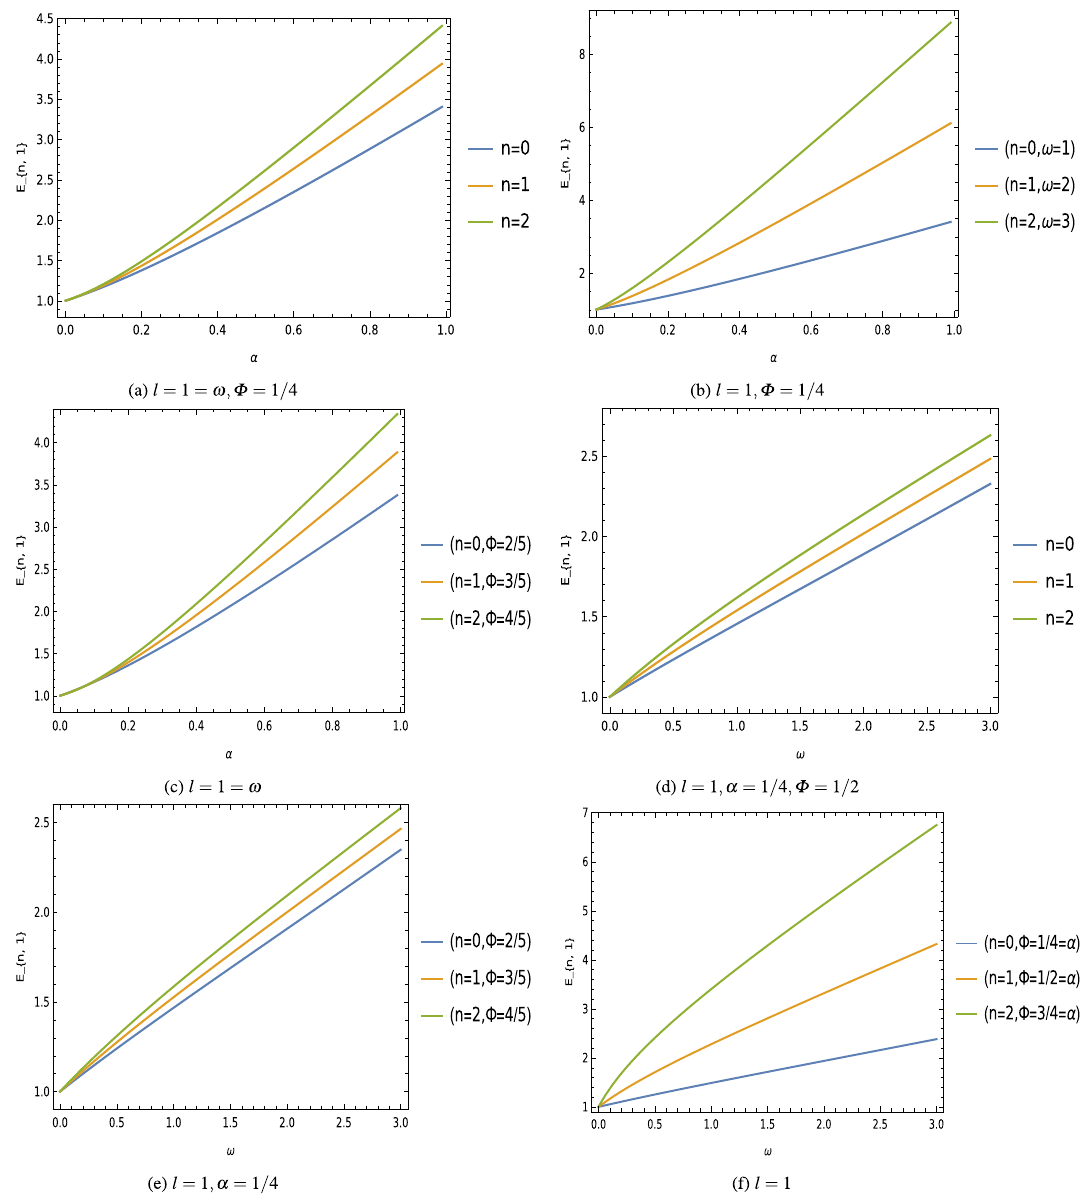
Figure 2. Eigenvalues E n ,1 keeping fixed M = 1 = b = a , ξ = 1 / 2 [unit of different parameters are chosen in natural units ( c = 1 = (cid:31) )